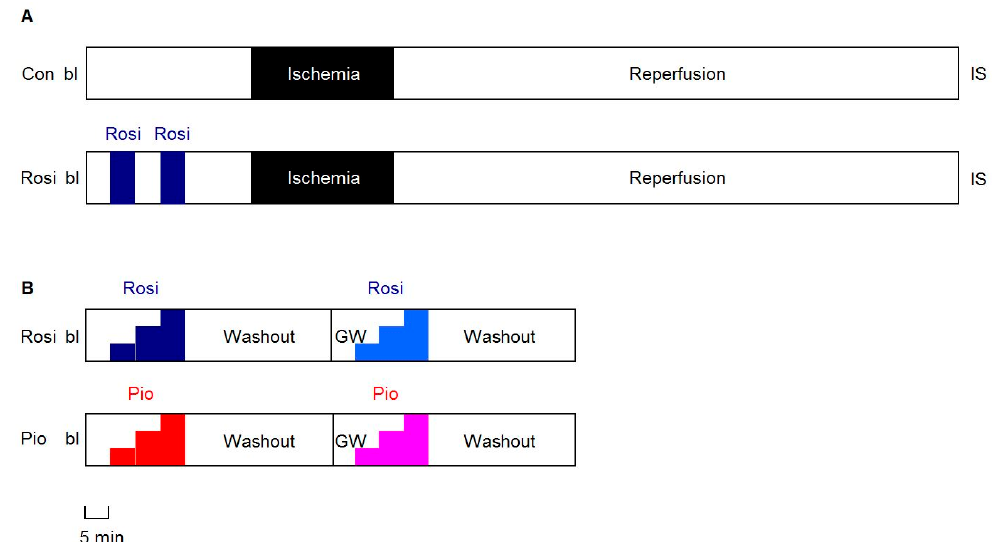
Figure 1. Shows the experimental protocols. The hearts were isolated from eight-week-old male Brown Norway rats and mounted in a Langendorff setup. After 20 min equilibration and a baseline (bl) reading, the hearts in the first set of experiments (n = 12; Panel ( A )) were given rosiglitazone (Rosi, 50 µM) or a vehicle (Con) for two times, 5 min each with a 5 min washout period interspersed and followed by 15 min washout before 30 min of global no-flow ischemia and 120 min of reperfusion (IR) and subsequent infarct size (IS) determination. In a second set of experiments (Panel ( B )), the hearts were given increasing concentrations (2, 10, and 50 µM) of either rosiglitazone (Rosi, blue colors; n = 6) or pioglitazone (Pio, red colors; n = 6) for 5 min each followed by 30 min washout. This series was repeated in the presence of 10 µM of the PPAR γ antagonist GW9662 (GW, white). The hearts were not subject to IR or to IS determination.